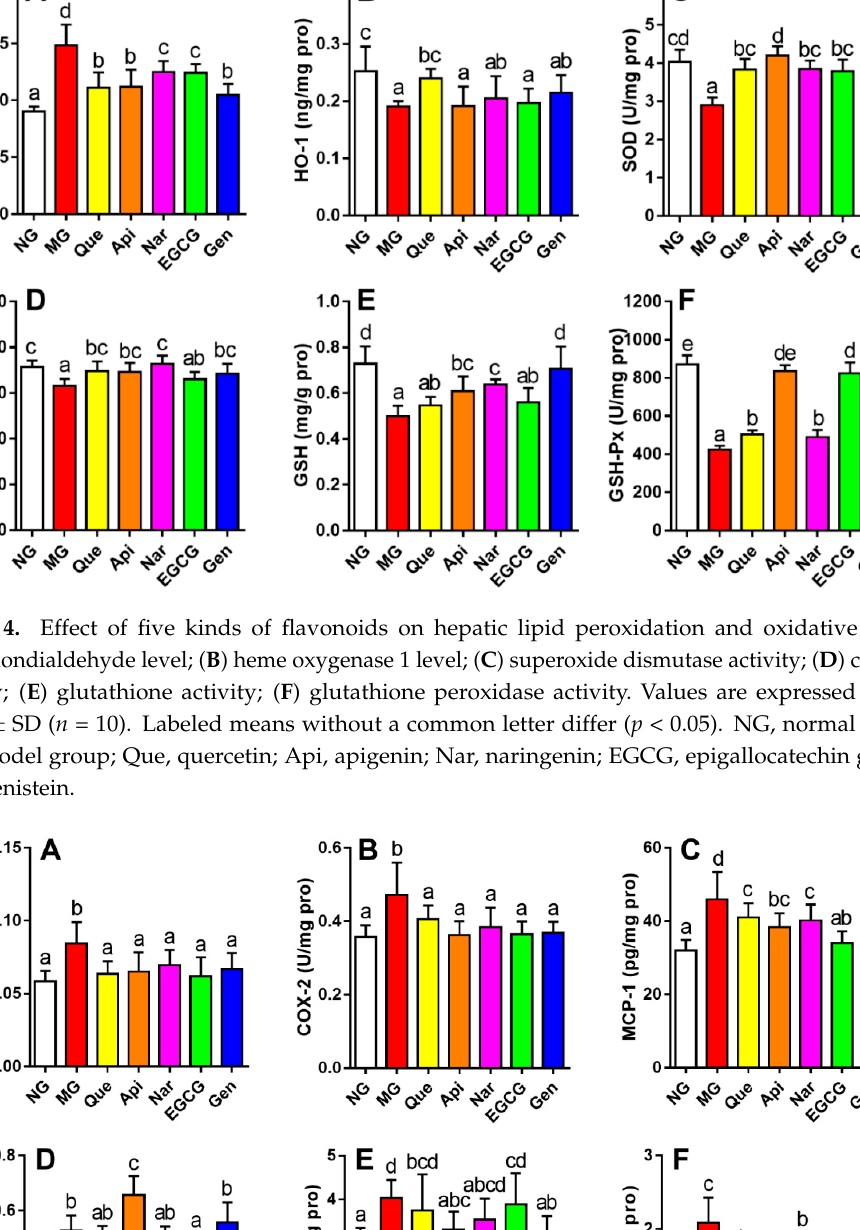
6 of 14 Figure 3. Effect of five kinds of flavonoids on hepatic lipid profiles: ( A ) hepatic total triglyceride level; ( B ) hepatic total cholesterol level. Values are expressed as the mean ± SD ( n = 10). Labeled means without a common letter differ ( p < 0.05). NG, normal group; MG, model group; Que, quercetin; Api, apigenin; Nar, naringenin; EGCG, epigallocatechin gallate; Gen, genistein; TG, total triglyceride level; TC, total cholesterol level. 3.4. Effect of Five Kinds of Flavonoids on Hepatic Lipid Peroxidation and Oxidative Stress As shown in Figure 4, the hepatic MDA level in the mice induced by alcohol consumption was remarkably augmented and the activities of HO-1, CAT, SOD, GSH, and GSH-Px were apparently inhibited as compared with those in the NG ( p < 0.05). The production of hepatic lipid peroxidation product and oxidative stress was inhibited to varying extents resulting from the treatment with